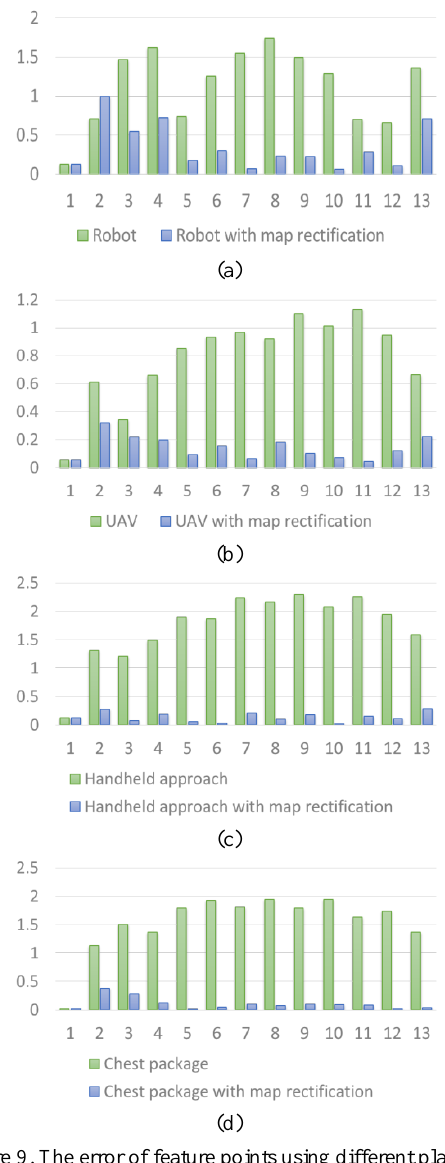
Figure 9. The error of feature points using different platforms with map rectification at 3F. (a) shows the error using robot; (b) shows the error using UAV; (c) shows the error using handheld approach and (d) shows the error using chest package